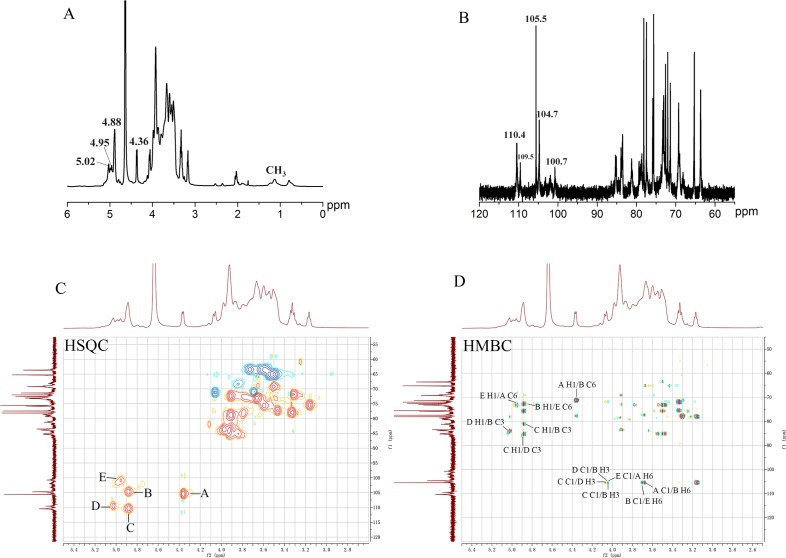
(A) 1H NMR spectrum of UP2 in D2O; (B) 13C NMR spectrum of UP2 in D2O; (C) HSQC NMR spectrum of UP2 in D2O; (D) HMBC NMR spectrum of UP2 in D2O.